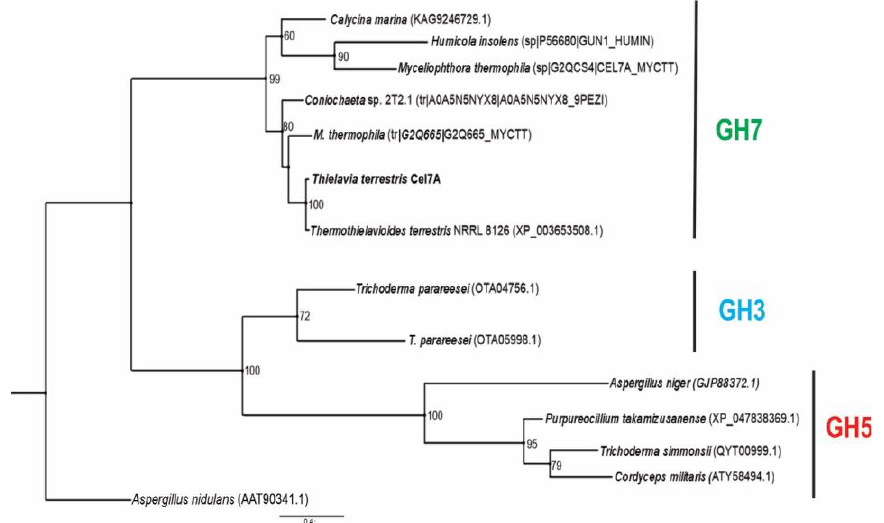
Figure 12. Maximum likelihood phylogenetic tree of the bifunctional cellulase/xylanase TtCel7A amino acid sequence from T. terrestris Co3Bag1 and the representative sequences of GenBank and Uniprot databases. The Blosum62+G+F model (−InL 14,779.55, gamma parameter 8.079) was used for the analysis. As an outgroup, the putative endoglucanase sequence of A. nidulans of the GH17 family (AAT90341.1) was included. The robustness at each node was assessed after 1000 pseudoreplicates, and bootstrap support values are indicated for major nodes having 50% values. The scale bar indicates substitution/site.